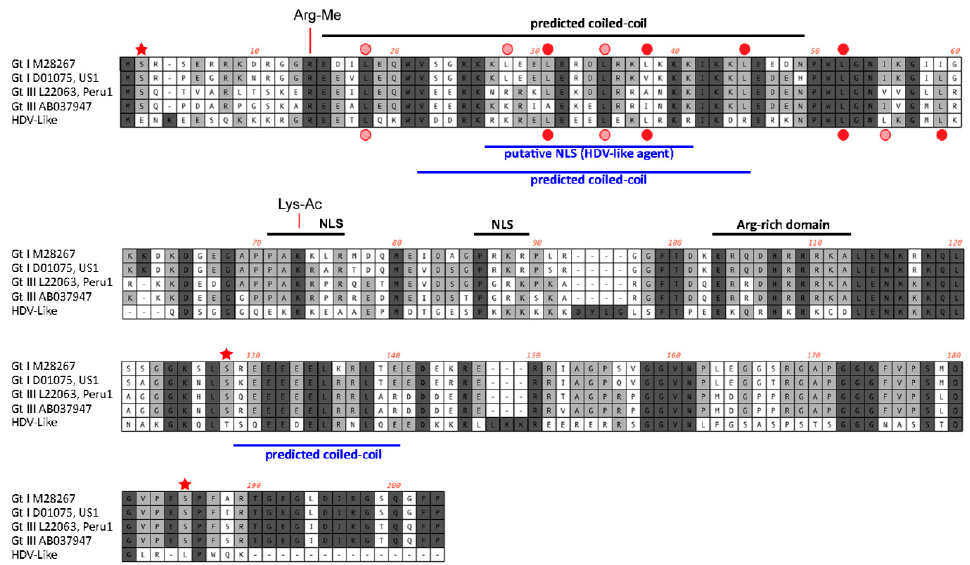
Figure 4. Features of the predicted HDAg protein. Alignment of the amino acid sequences (small delta antigen) translated from the genomes of HDV and the avian HDV delta-like agent. The potential coiled-coil region is highlighted, including the presence of leucine residues in the correct spacing for a leucine zipper (filled red circle). The delta antigen does not have a strict requirement for leucine in the d-position of the heptad repeat. Additional leucine residues are shown by circles in light red. Serine residues that are conserved between different HDV genotypes and post-translationally modified (phosphorylated) are highlighted with an asterisk. The conserved arginine and lysine residues modified by methylation (Arg-Me) and acetylation (Lys-Ac) are indicated. NLS: Nuclear localisation signal.